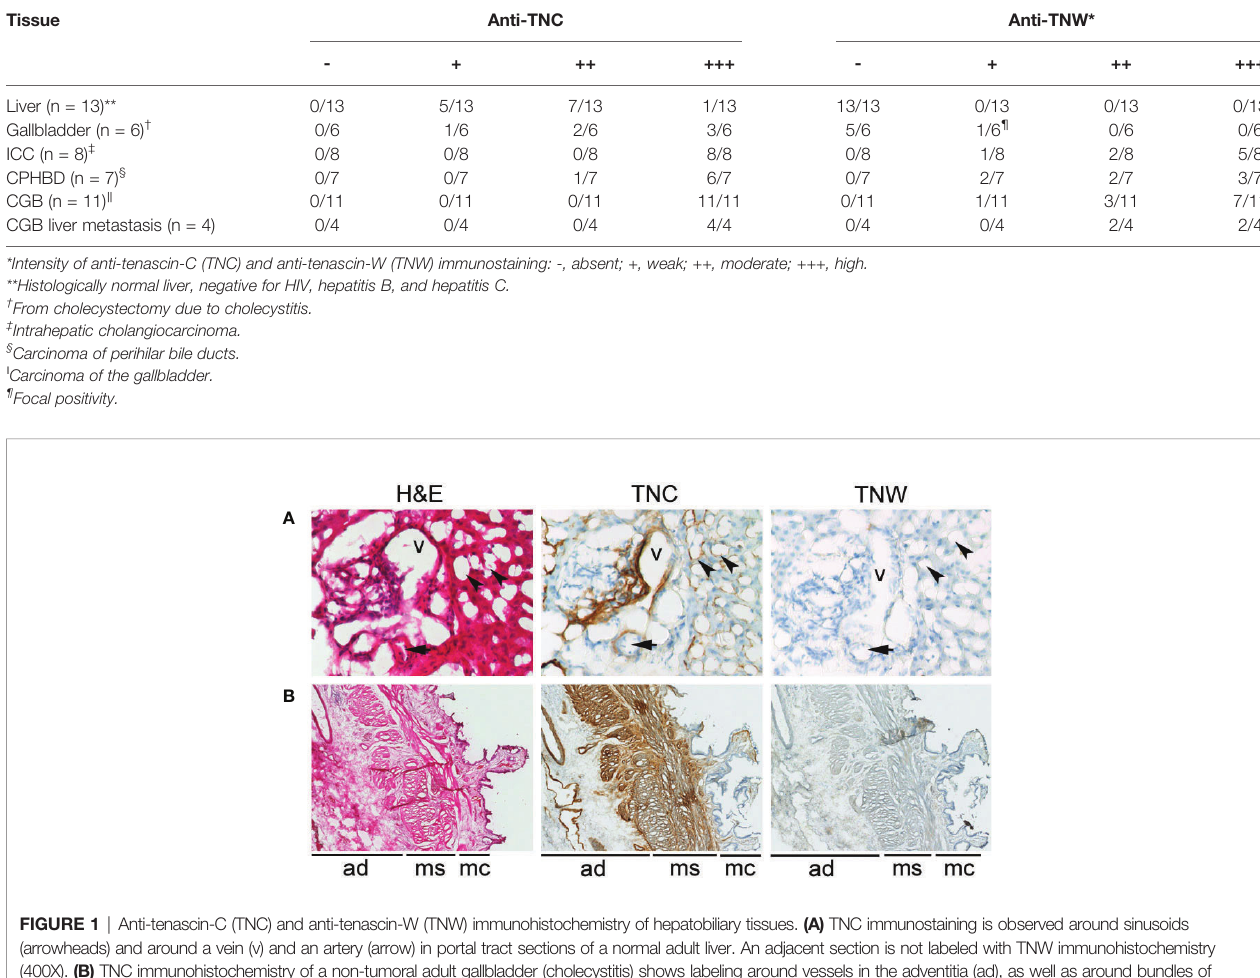
TABLE 1 | Summary of tenascin immunostaining of normal liver, non-tumoral gallbladder, and hepatobiliary cancers.